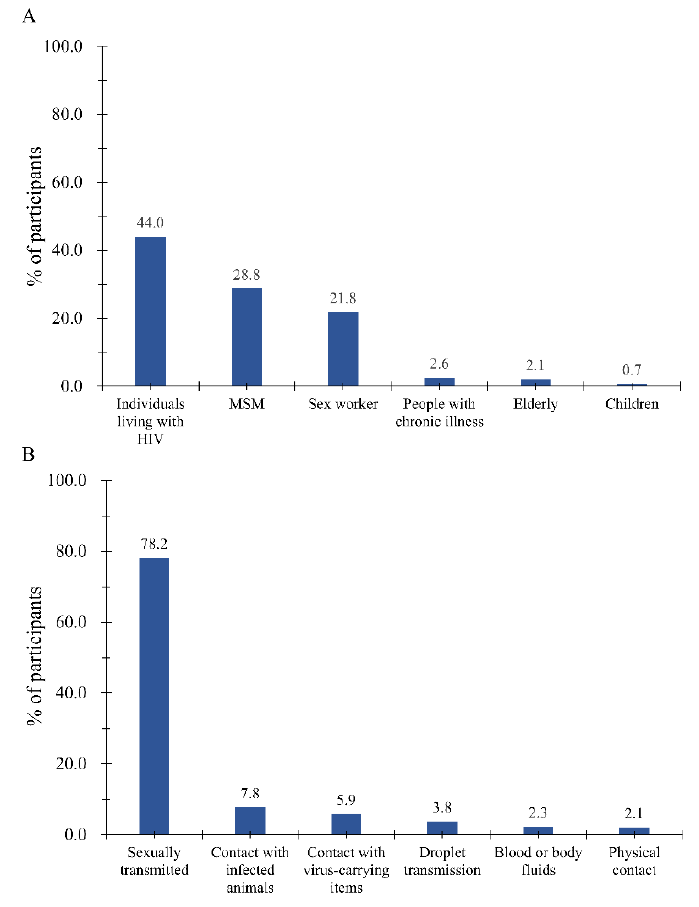
Figure 1. Participates’ perceived groups at high risk ( A ) and dominant transmission route of Mpox ( B ). An elderly person is defined as anyone over the age of 60. A child is defined as anyone under the age of 18.